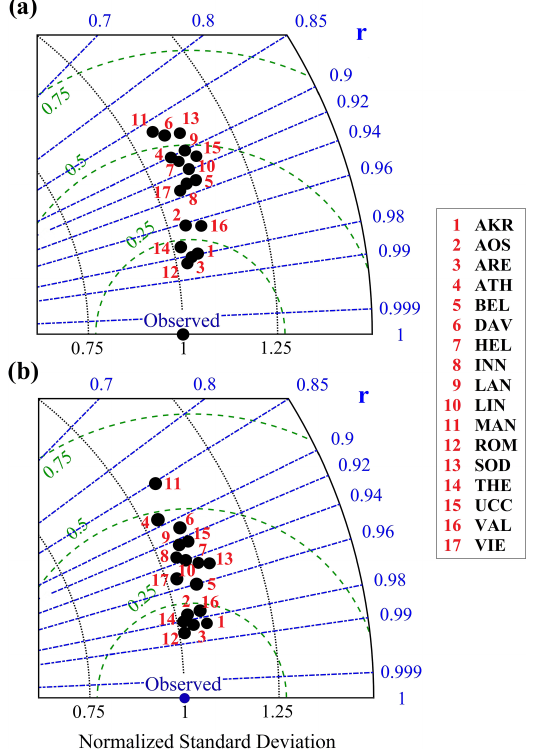
Figure 6. Taylor diagram for the overall UVIOS accuracy for all ground stations under all-sky (a) and clear-sky (b) conditions.